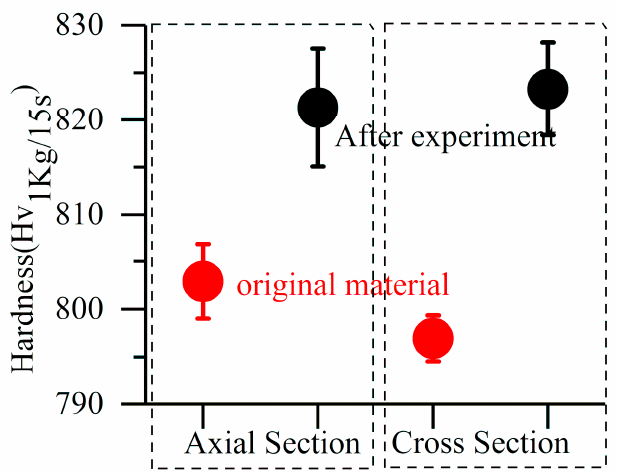
Figure 7. Hardness change of cylinder sample before and after experiment.